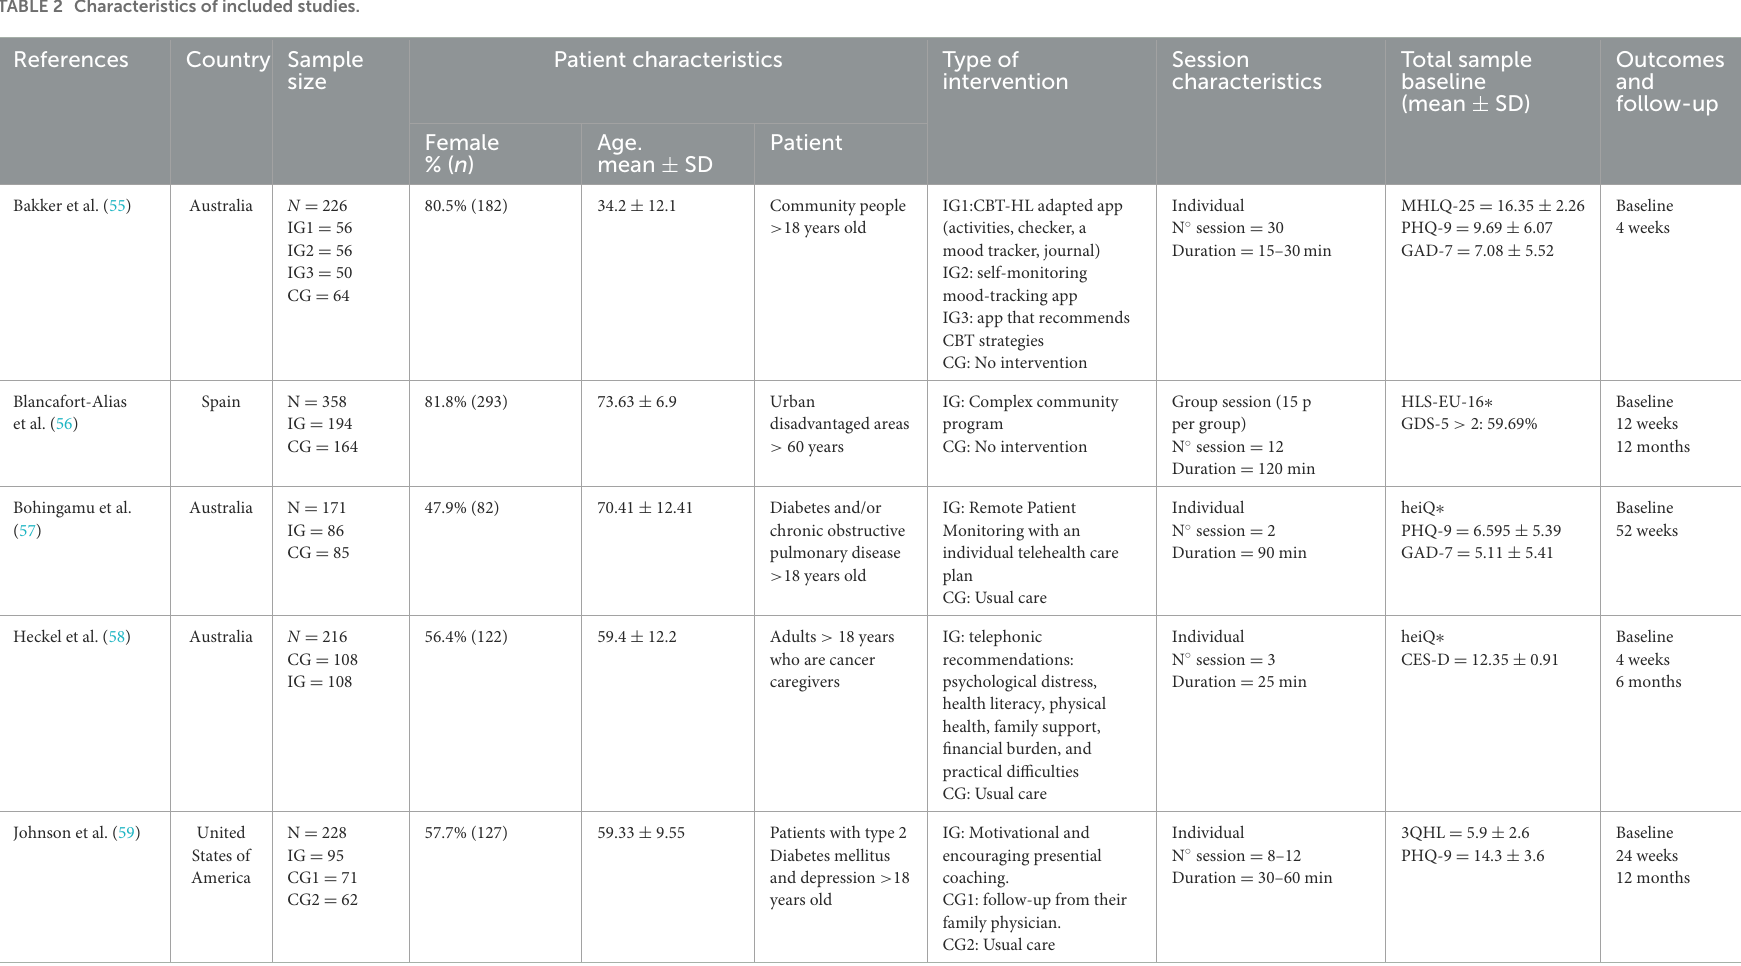
TABLE 2 Characteristics of included